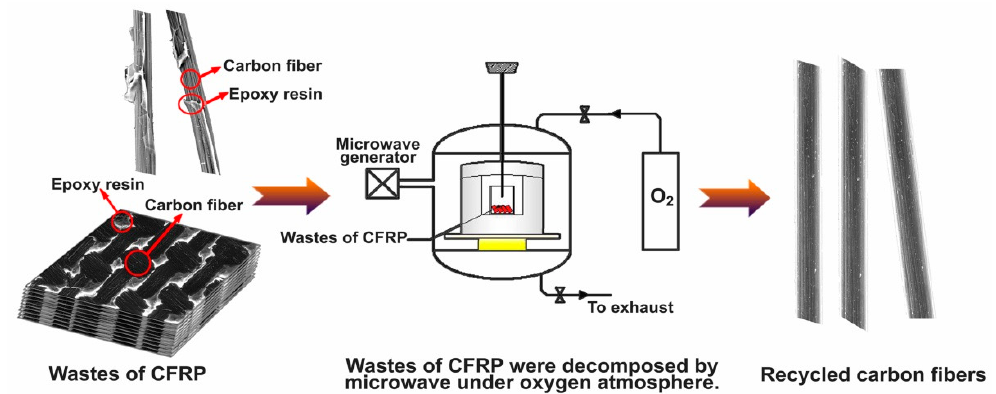
Figure 1. Schematic of carbon fiber-reinforced polymer (CFRP) waste treatment by microwave thermolysis.